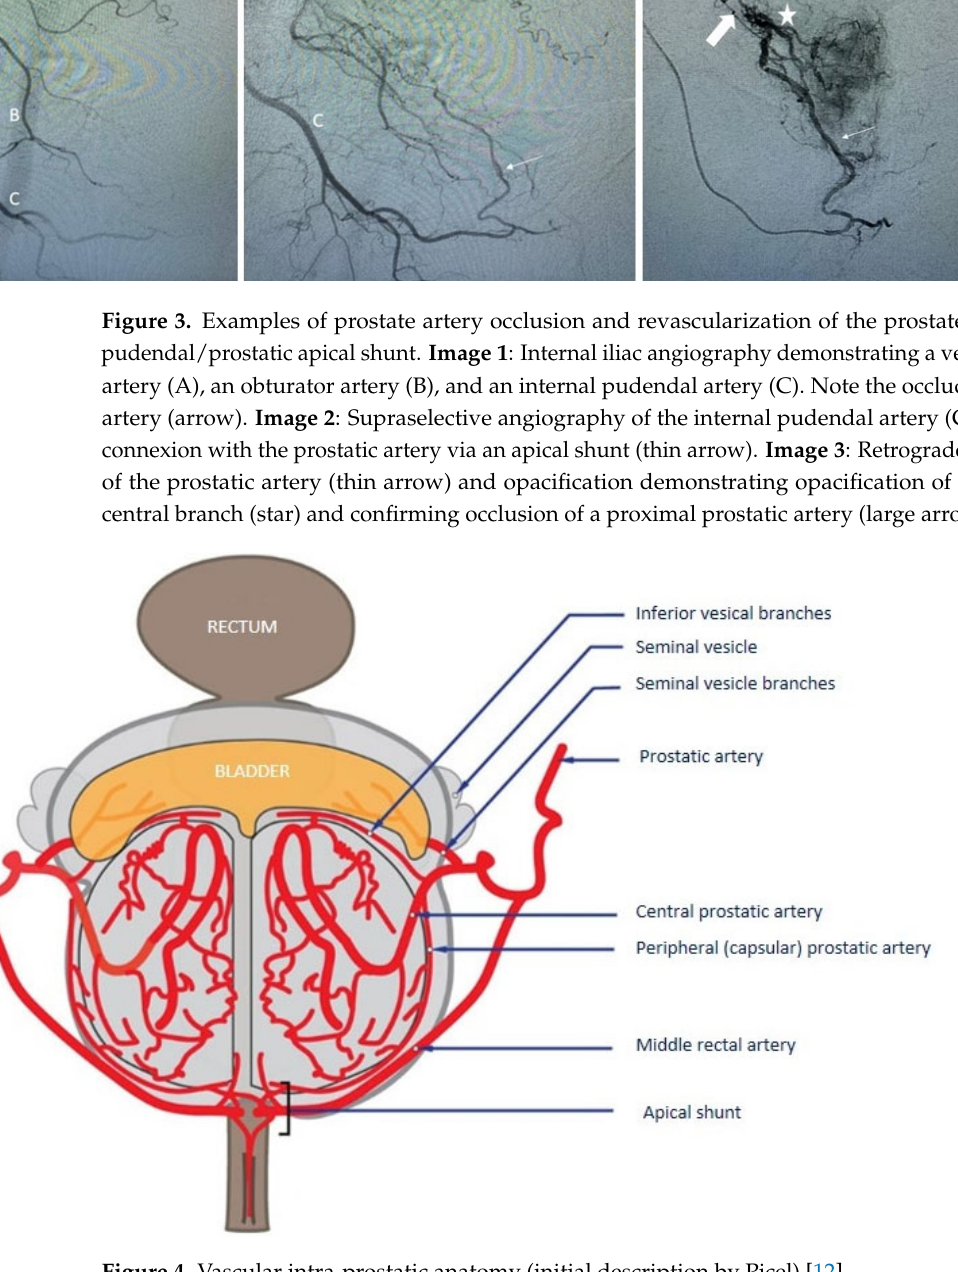
Figure 4. Vascular intra ‐ prostatic anatomy (initial description by Picel)